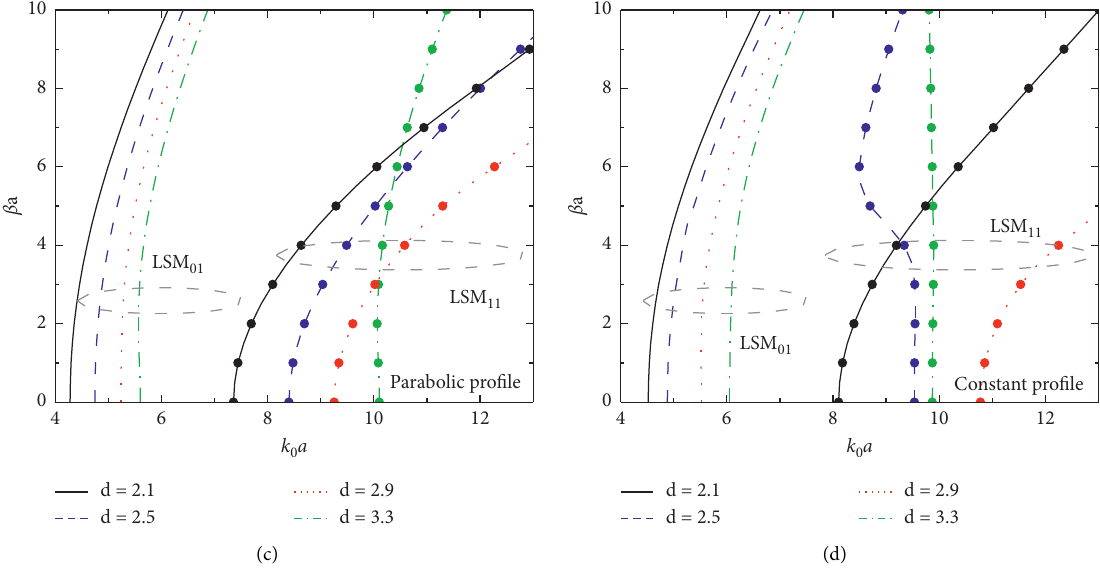
Figure 8: The dispersion relations of the LSM modes with various values of the profile parameter d and step width of Δ d � 0 . 4: (a) exponential profile; (b) linear profile; (c) parabolic profile; (d) constant